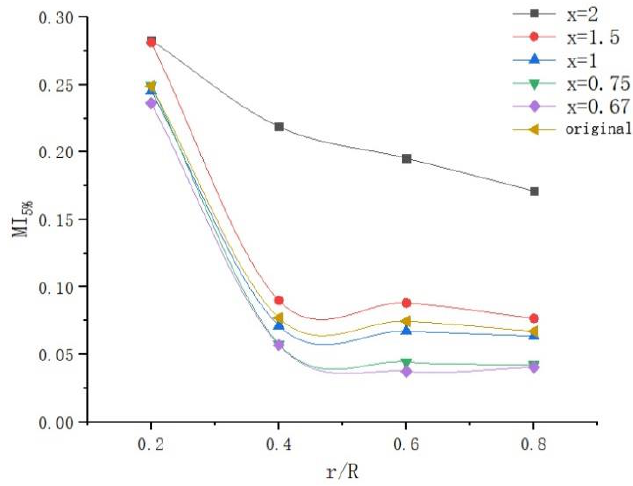
Figure 12. Influence of different scale-up criteria on the MI curve with 5% solid volume fraction.